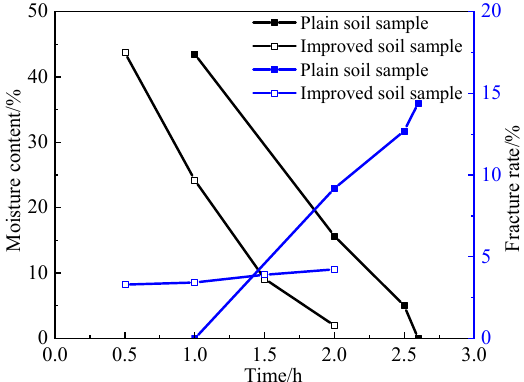
Figure 13. Comparison curve between the improved soil and the plain